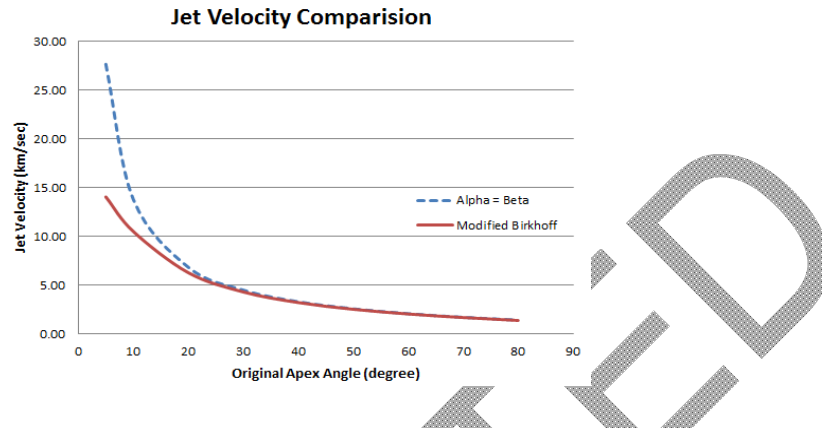
Figure 10. Jet and slug velocity depending on the original apex